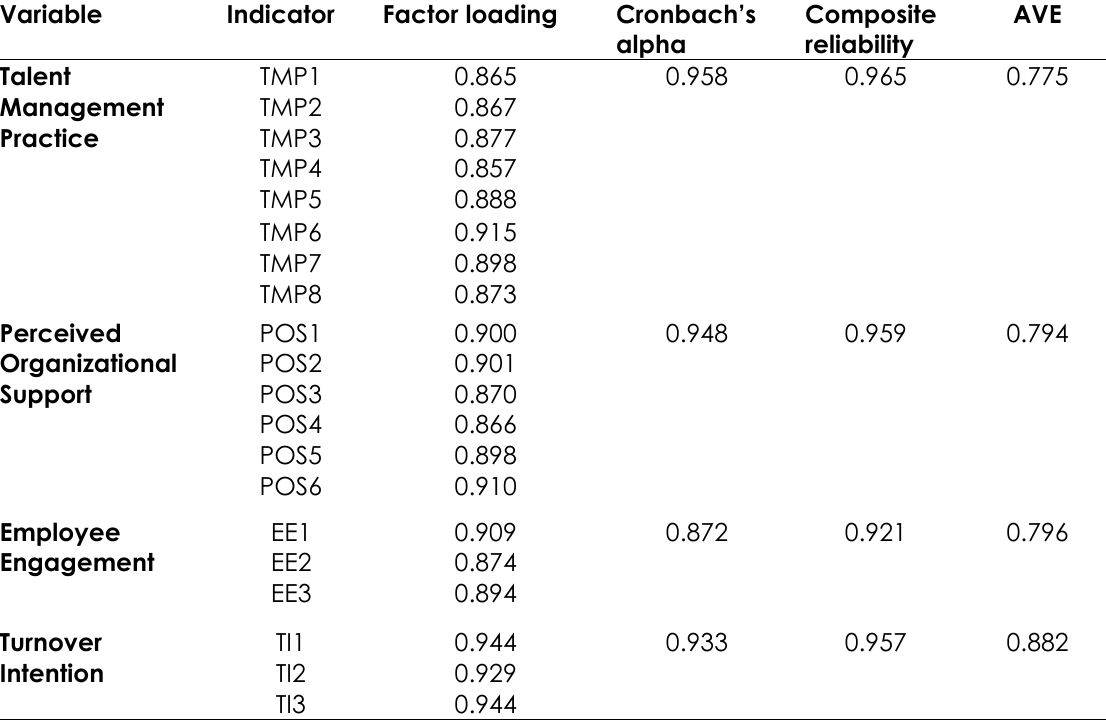
Test Results of Measurement Model in